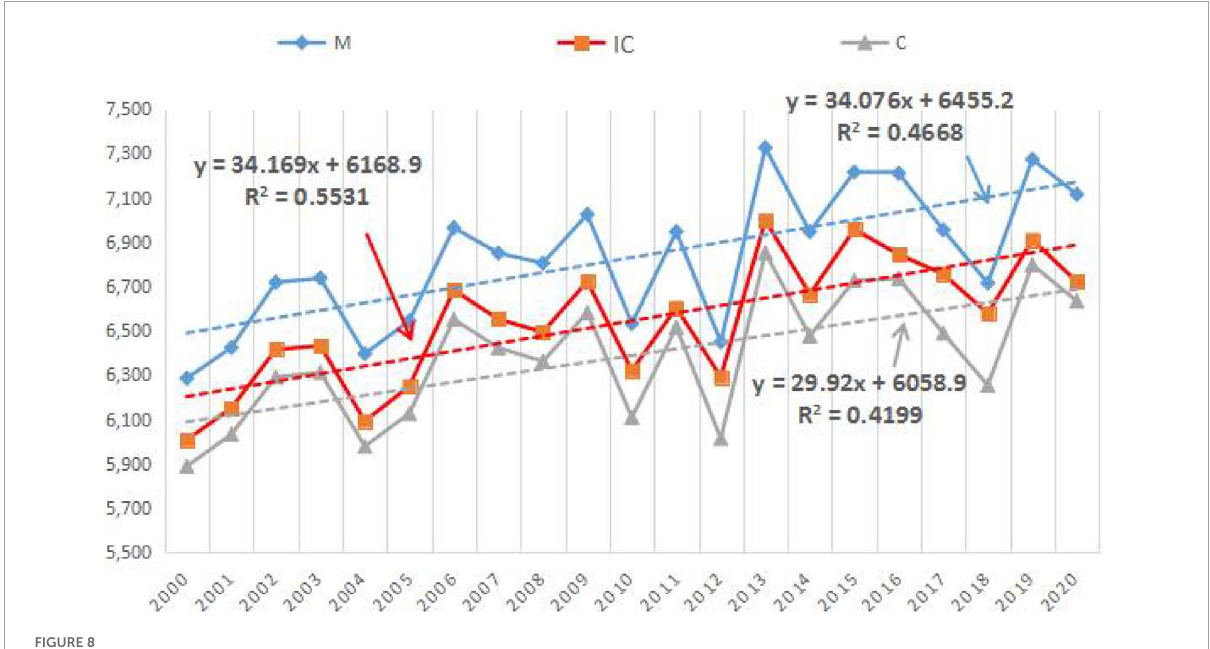
FIGURE8 Trends of forest carbon sequestration estimated by the three methods from 2000 to 2020.